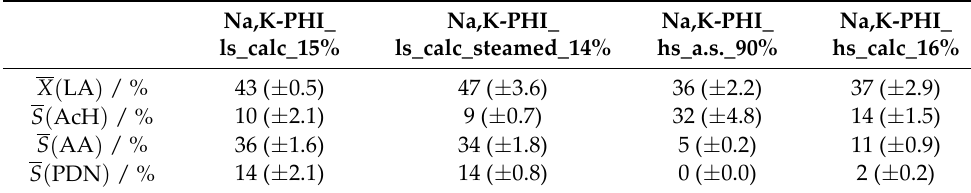
Table 1. Catalytic performance of the zeolites during the reaction of lactic acid. The mean conversion of lactic acid X ( LA ) and the mean selectivities to acetaldehyde S ( AcH ) , acrylic acid S ( AA ) and 2,3‑pentanedione S ( PDN ) over the total TOS of 285 min are shown. The standard deviation of the mean values to the individual measuring points is given in parentheses. Na,K‑PHI_ls_calc_15% was measured twice to show reproducibility, the mean values and standard deviation were calculated over both measurements. Na,K‑PHI_ls_calc_steamed_14%, Na,K‑PHI_ hs_a.s._90% and Na,K‑PHI_ hs_calc_16% were measured once. Reaction conditions: 0.5 g catalyst, LHSV = 3 h